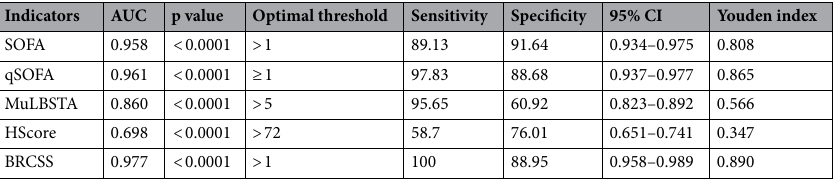
Indicators AUC p value Optimal threshold Sensitivity Specificity 95%